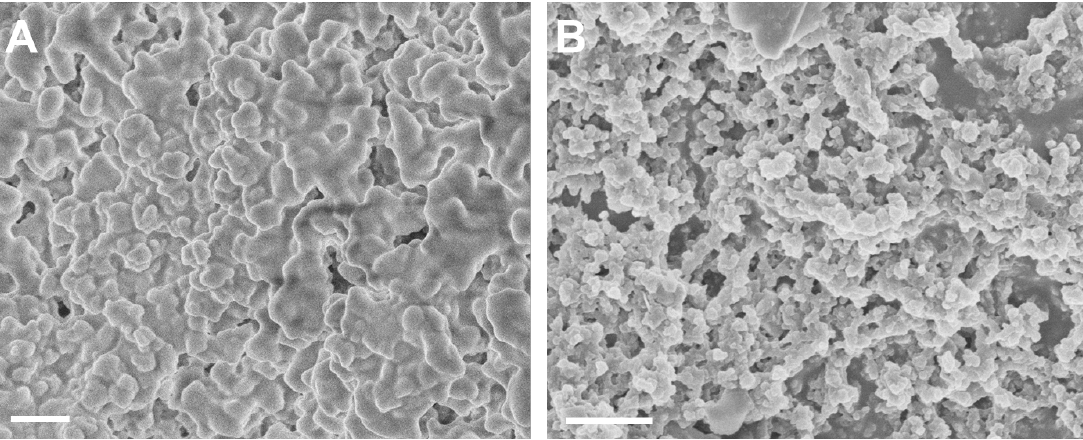
Figure 1. SEM images of PZnTEP polymeric material ( A ) PZnTEP organogel deposited as a film on glass and ( B ) a portion of PZnTEP xerogel, scale bar 1 µm.